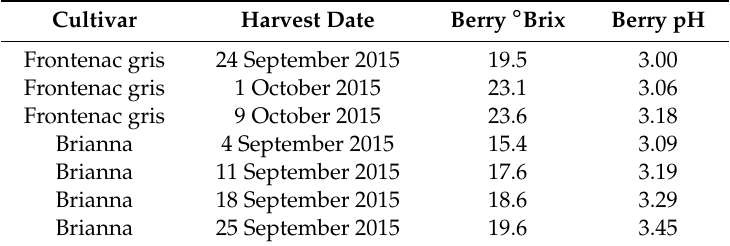
Table 2. Brianna and Frontenac gris grapes’ characteristics at